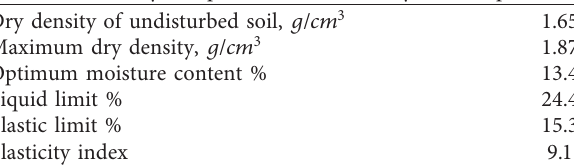
Figure 1: Particle size distribution of the silty soil. Table 2: Physical parameters of the silty soil